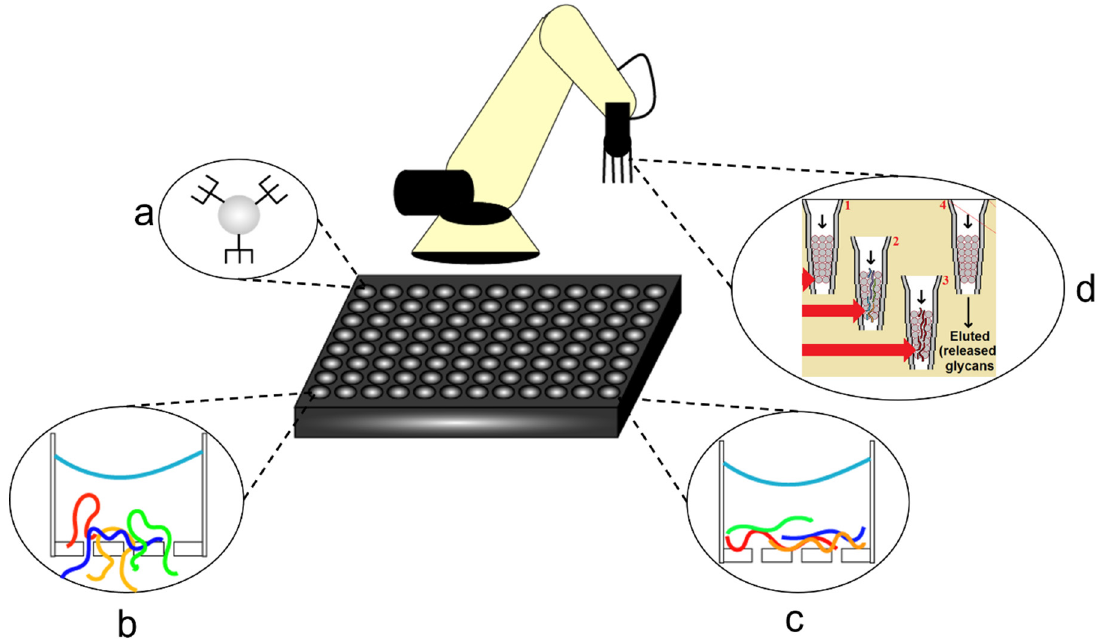
Figure 11. Microplate-based methods for high-throughput and automated sample preparation: ( a ) magnetic beads used for high-throughput separations or magnetic pelleting; ( b ) MStern blot adsorption of proteins to the well for separation; ( c ) filter-aided sample processing (FASP) for separating proteins using molecular weight cutoff (MWCO); ( d ) in-tip digestion of protein samples using an automated, modified pipette and a 96-well plate robot. From Mafra et al. [147], Berger et al. [152], Switzar et al., Yu et al., Wisniewski et al. [153–155], and Yang et al. [41,156].